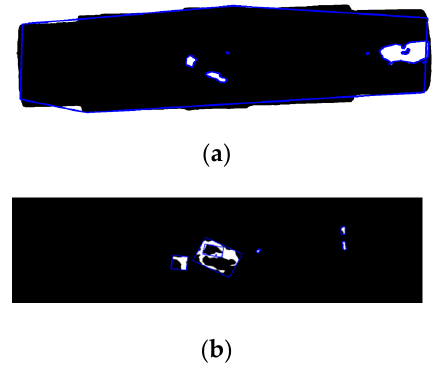
Figure 8. Edge fitting. ( a ) Polygon fitting; ( b ) Rectangular fitting.